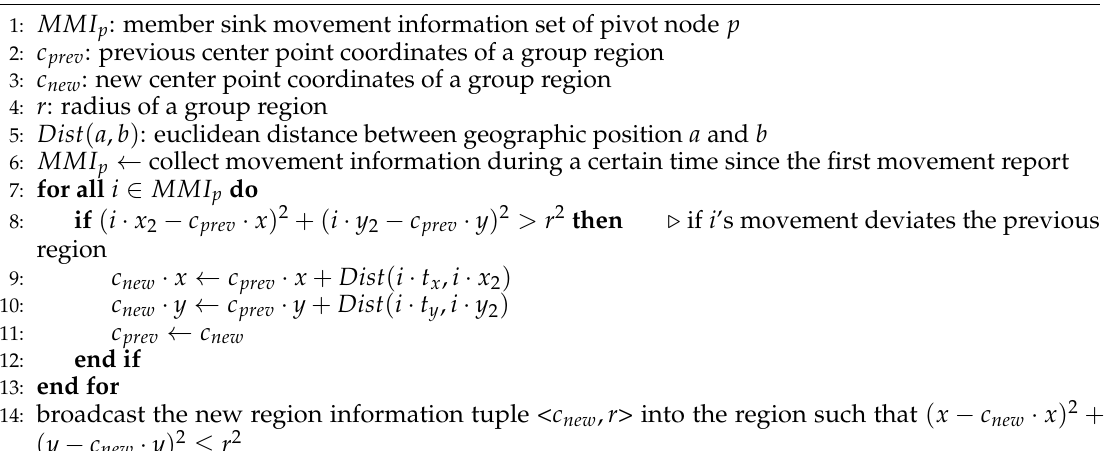
Algorithm 1 Basic algorithm of region shift at a pivot node.